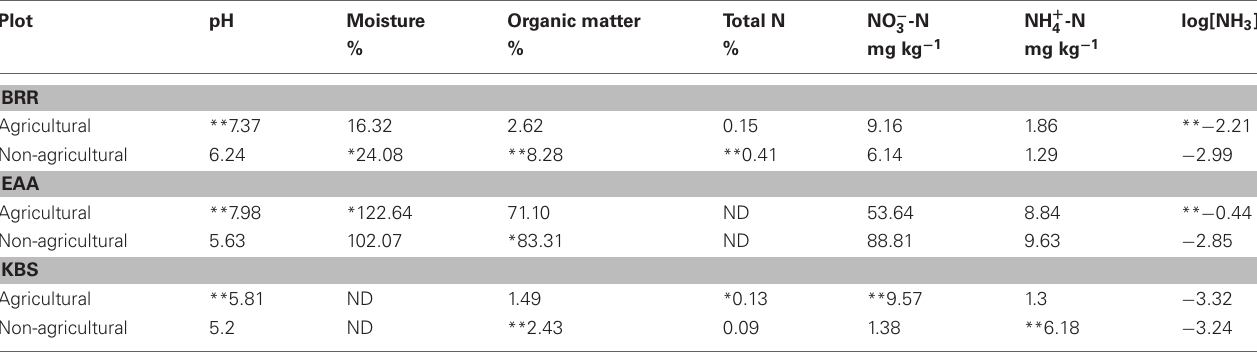
Table 4 | Soil properties of agricultural and non-agricultural soils at Broadbalk Experiment at Rothamsted Research (BRR), the Everglades Agricultural Area (EAA) and the Kellogg Biological Station